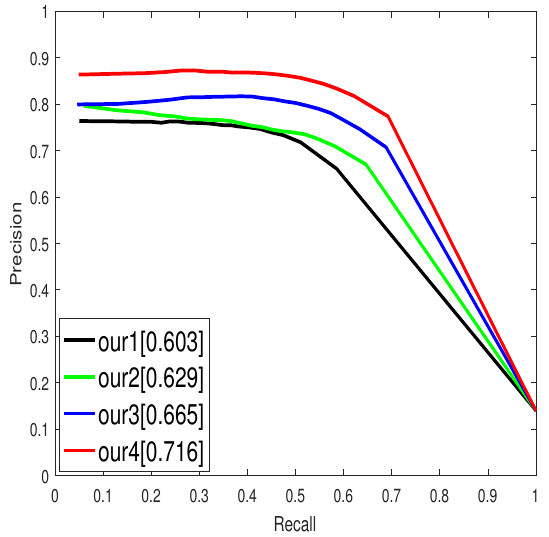
Figure 5. PR curves of our approach with its variants on the entire